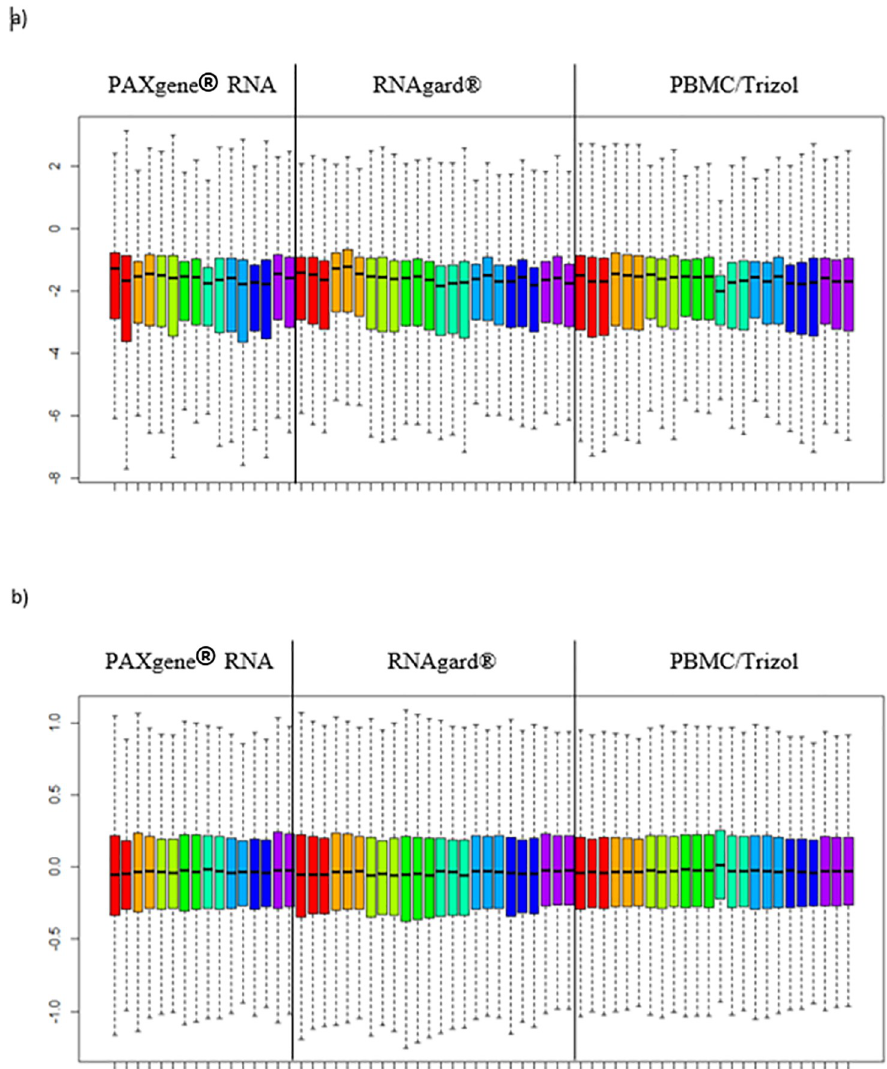
Fig 1. Microarray signal intensity distribuiton before and after normalization. Raw (a) and normalized (b) microarray probe M values obtained for eight different individuals using three different blood collections systems. Colors represent individual